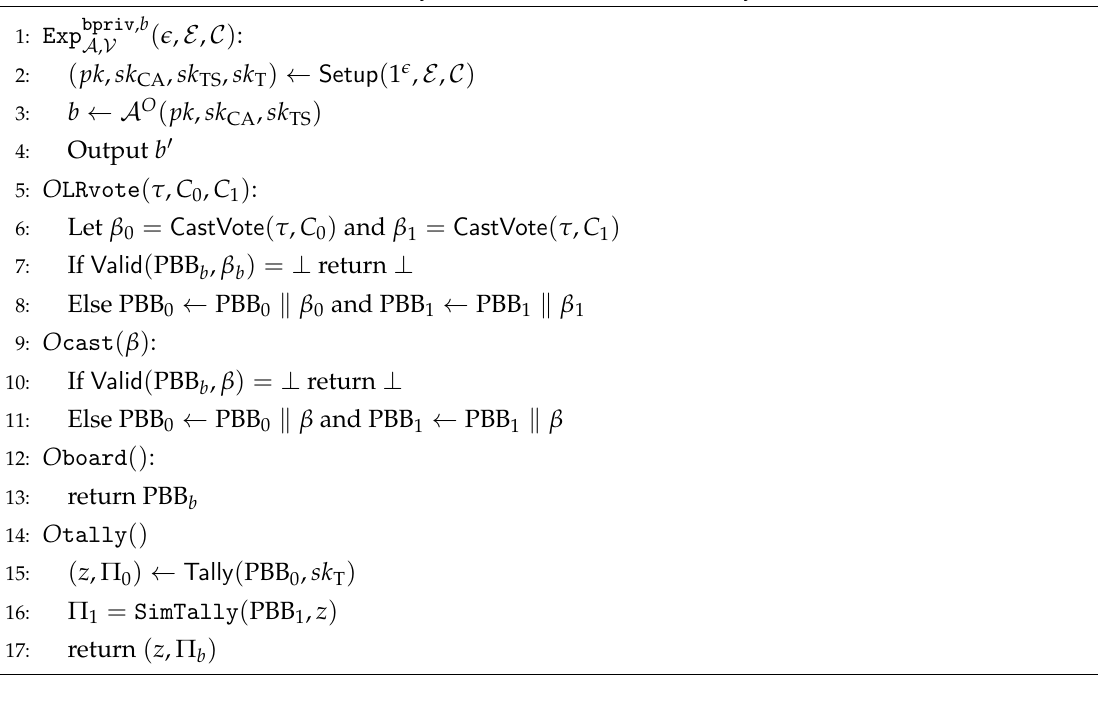
bpriv , b , the adversary A has access to the A , V